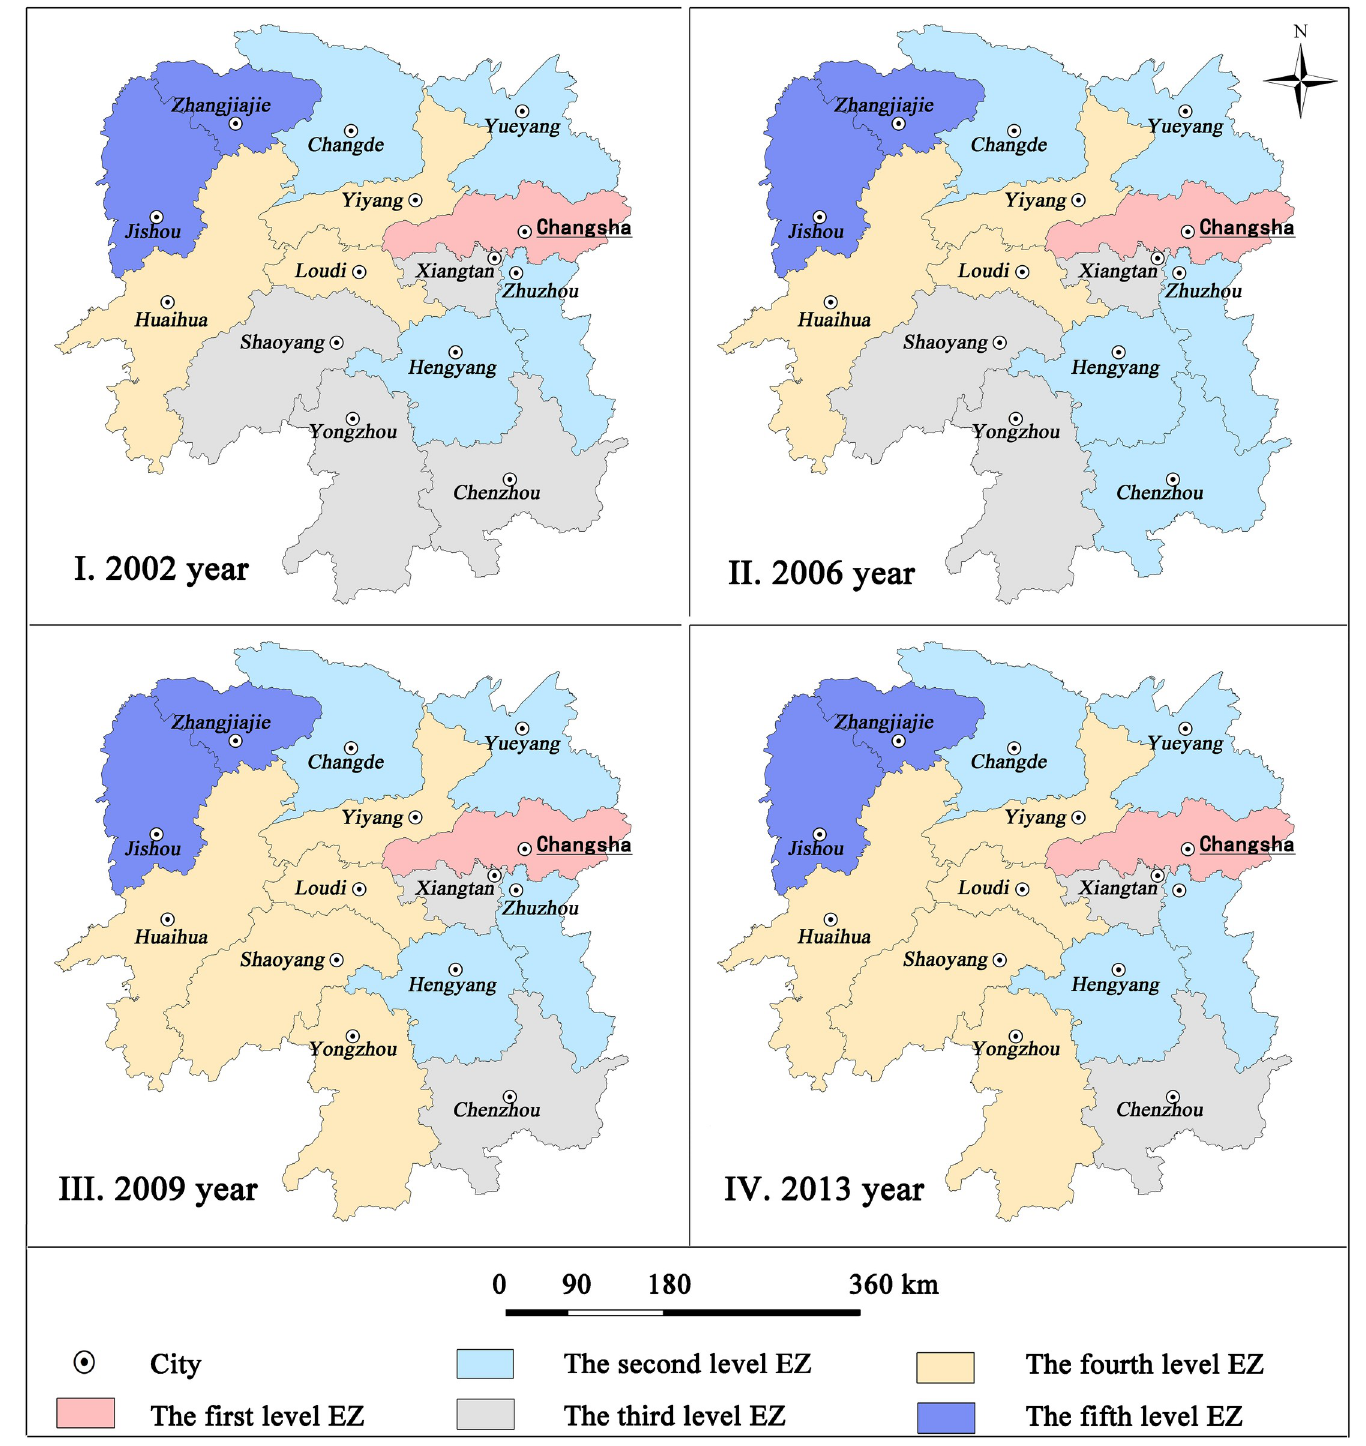
Fig 4. Temporal changes of traditional DEZ scheme of Hunan Province from 2002 to 2013. (Reprinted from http://www.ngcc.cn/ngcc/ under a CC BY license, with permission from the National Geomatics Center of China , original copyright 2012).